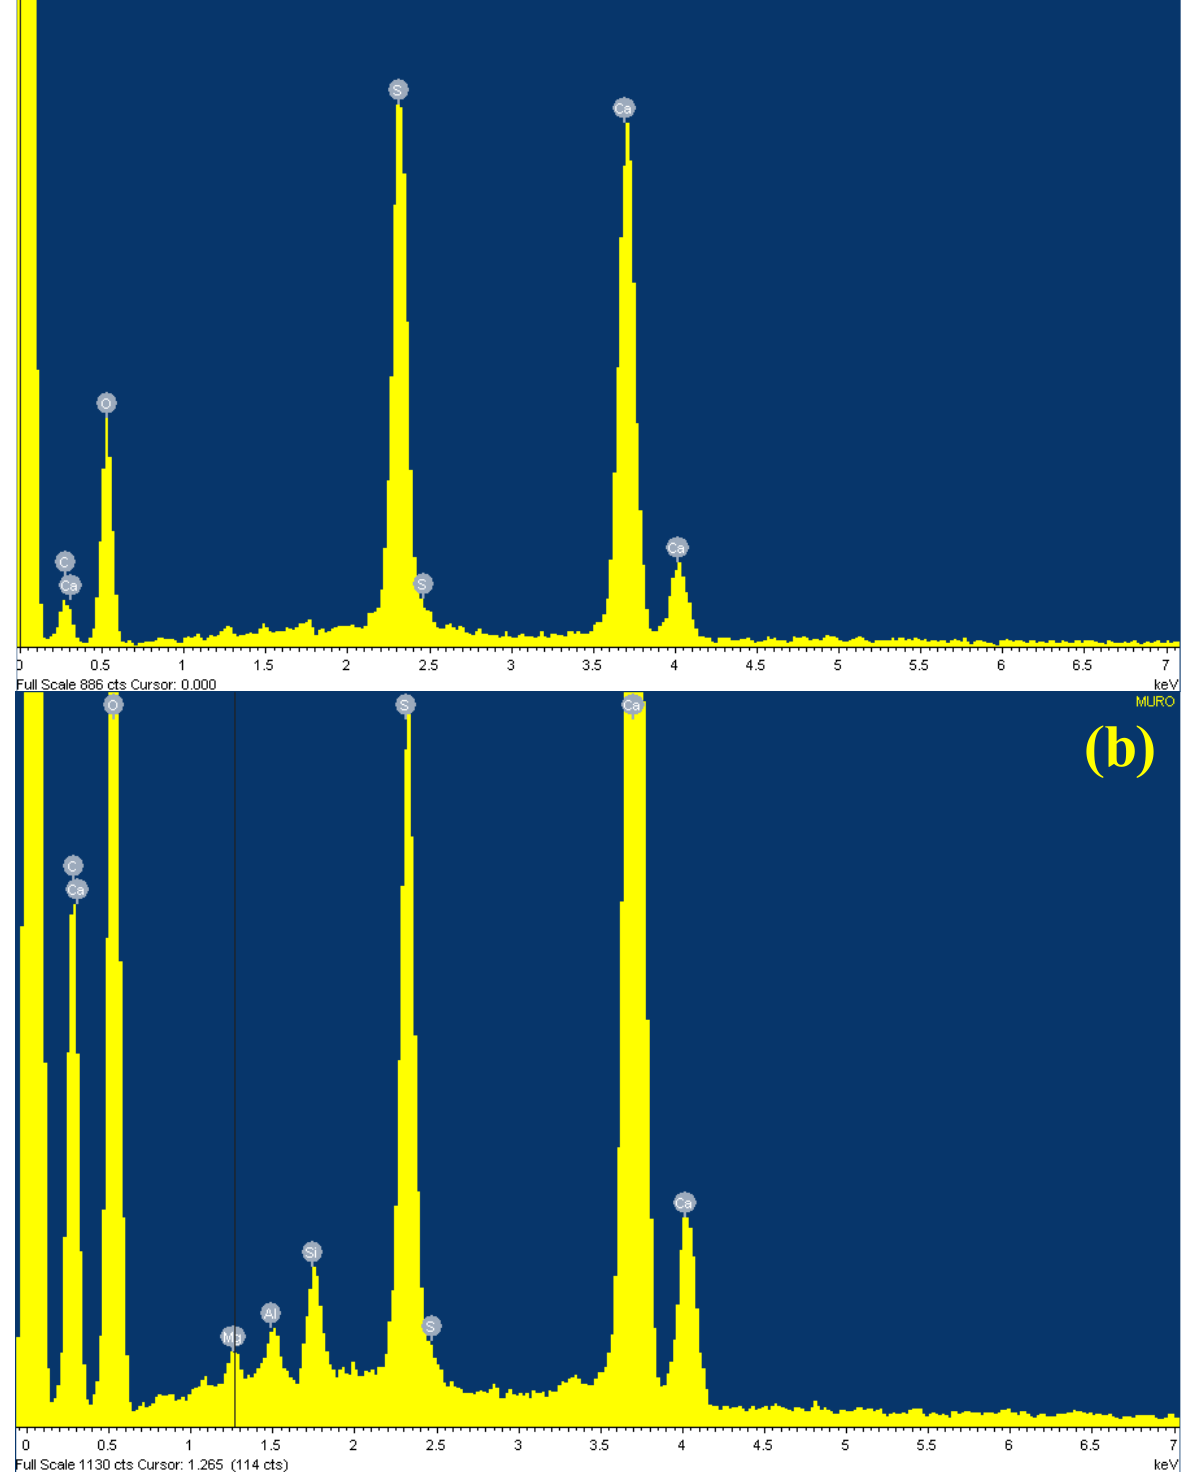
Figure 5. EDS spectra of ( a ) floor sample and ( b ) wall sample. For experimental condition: see Section 4 (Materials and Methods).